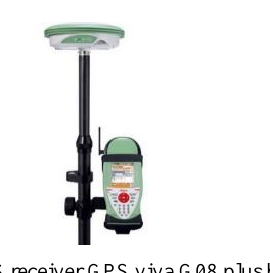
Figure 4. Monitoring the flight on the ground (25.07.2015)